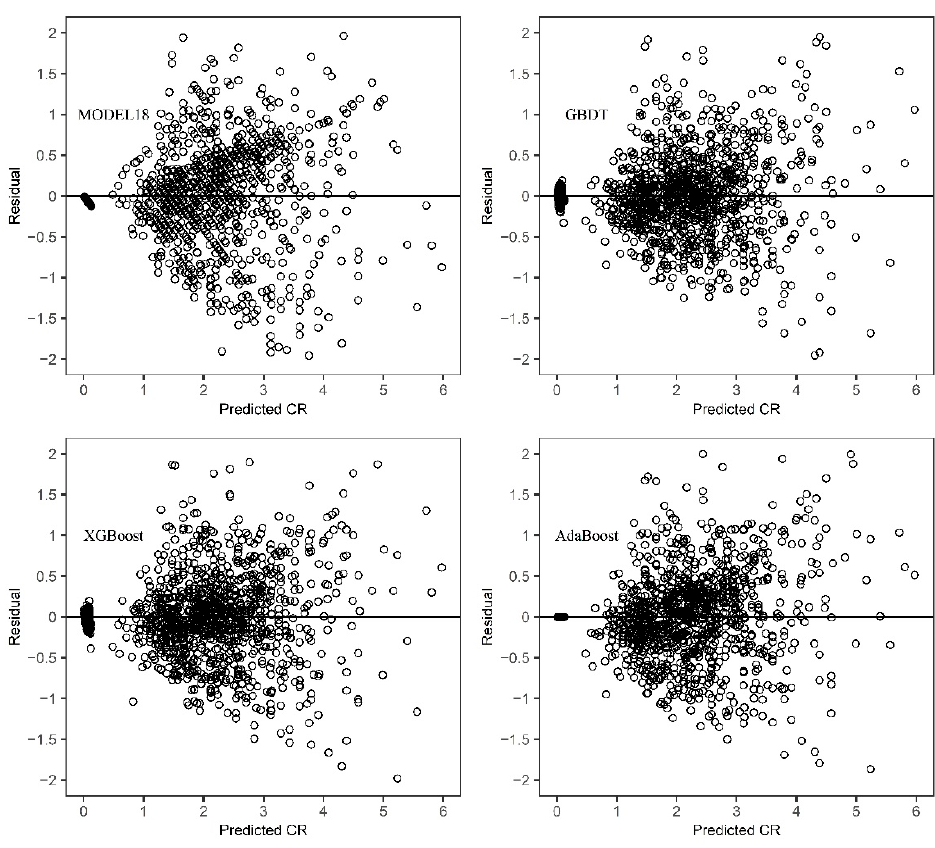
Figure 4. Scatterplots of CR predictions residuals for four